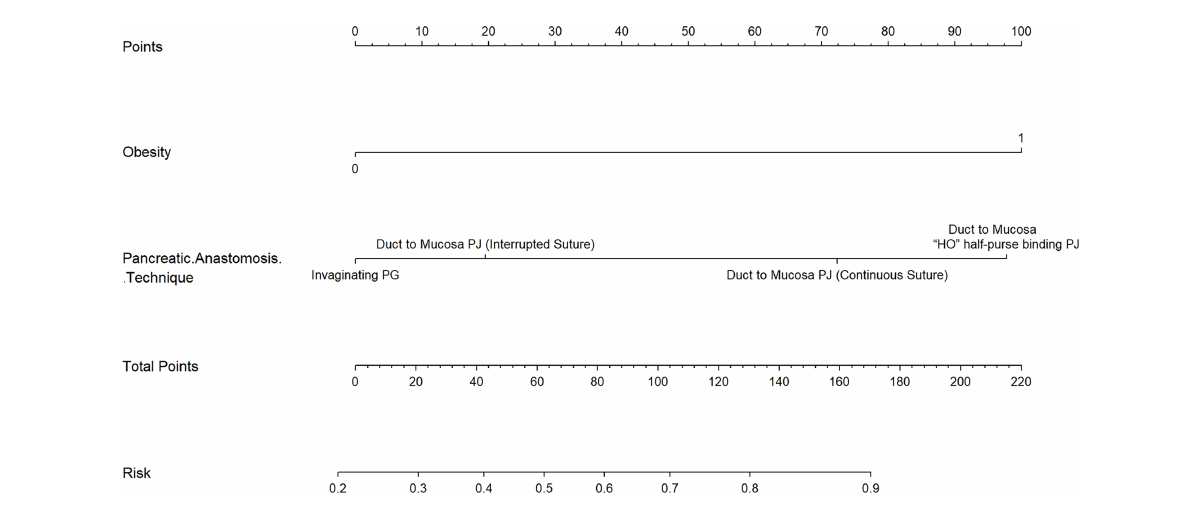
FIGURE 4 A Novel Nomogram for Predicting CR-POPF in OCP Patients. This nomogram is used by adding the points identi fi ed by each variable on the points scale. The sum of these points is projected on the bottom scale and indicates the rate of CR-POPF in individual patients. PJ: pancreaticojejunostomy; PG: pancreaticogastrostomy.